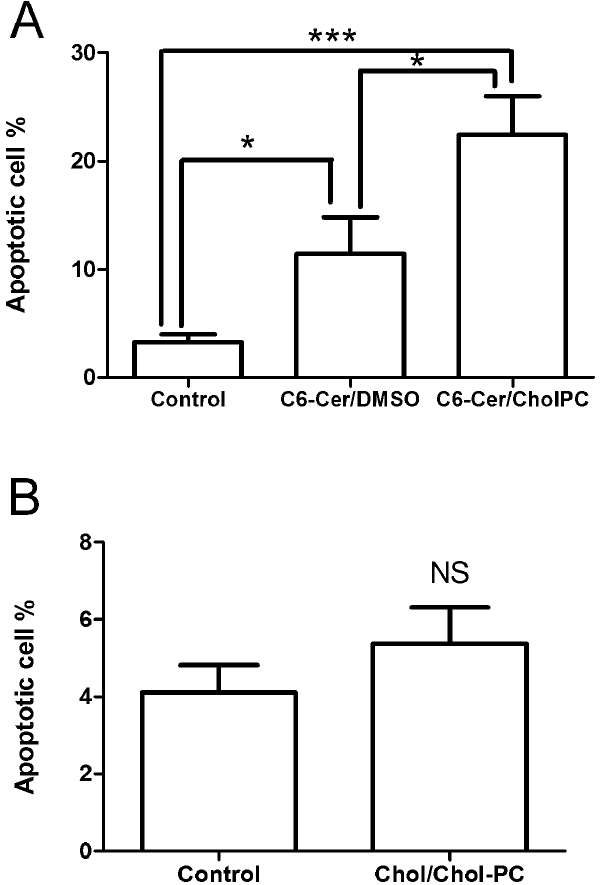
Figure 5. C6-Cer/CholPC and C6-dihydroCer reduce mitochon- drial calcium uptake. HeLa cells were preincubated for 180 min with 0.05 mM C6-Cer/CholPC or C6-Cer/DMSO (panels A and B), and changes in intracellular Ca 2 + levels were measured using mtAEQ. DMSO was added to control cells. Panel A shows kinetics of changes in mitochondrial Ca 2 + after challenge with histamine. In panel B, the change in Ca 2 + response was quantitated. The cells were challenged with 100 m M histamine as indicated by the arrow. Panel C shows kinetics of the Ca 2 + response after180 min exposure of cells to C6-